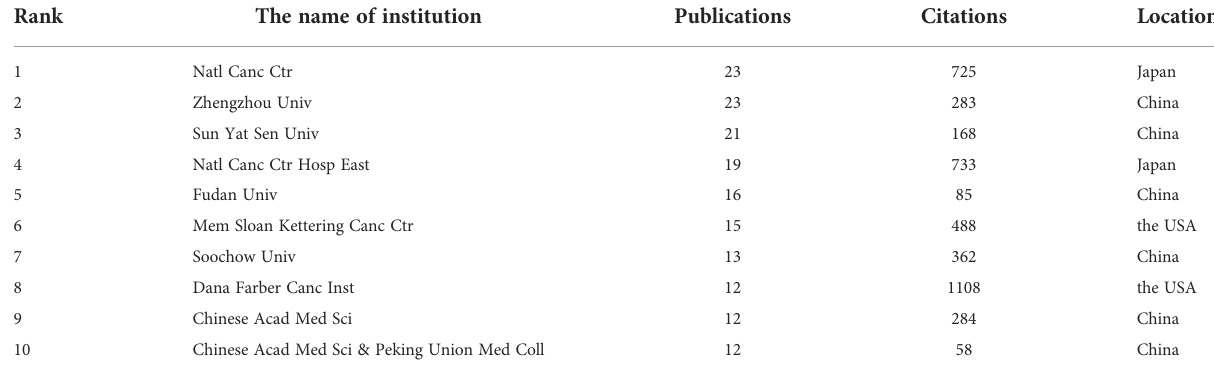
TABLE 2 The top 10 most productive institutions from 2012 to 2021.